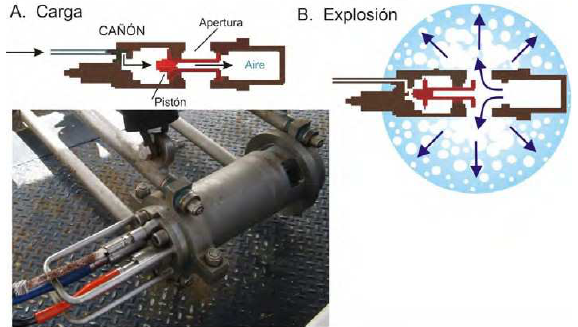
Figure 13. Photo detail of one of the guns and operation